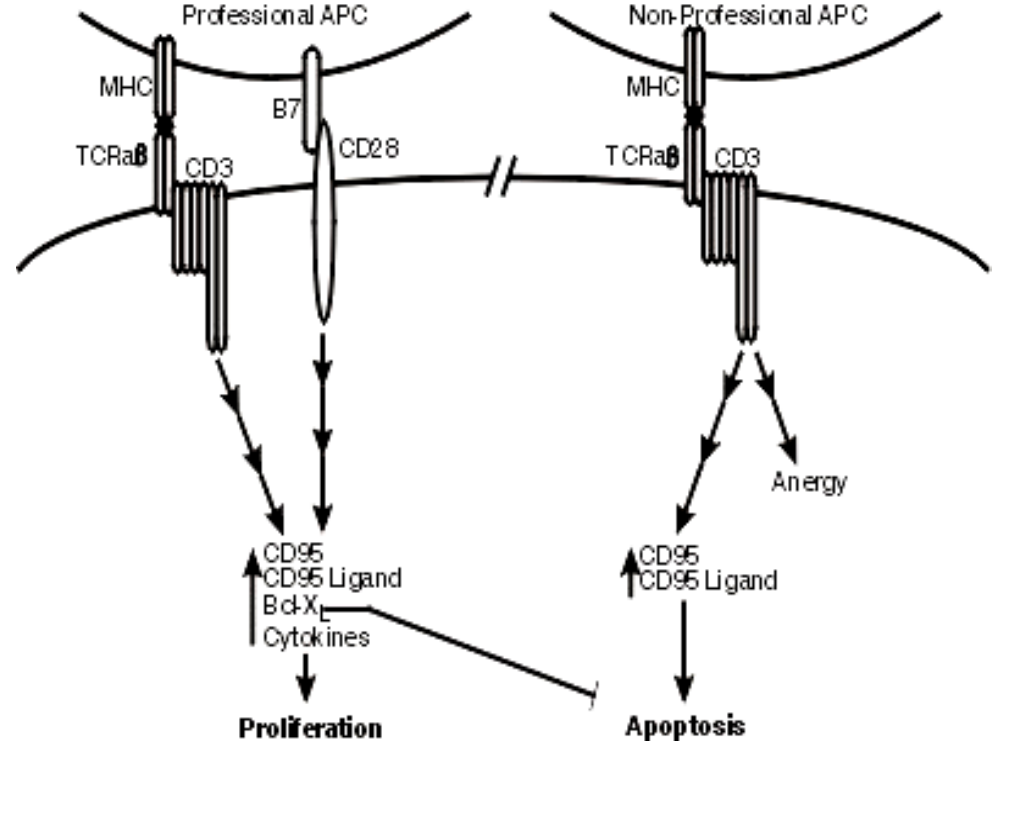
Figure 2: Pathways of T-cell stimulation [2] – The role of costimulation in delaying the onset of apoptosis induced cell death (AICD). Ligation of the T cell receptor in the presence or absence of costimulation results in increased expression of both CD95 and its ligand. However when professional antigen-presenting cells (APC) that express the B7 surface antigen stimulate T cells via CD28-mediated costimulatory signals, augmentation of TCR-induced cytokine production goes on for several days. The cells become susceptible to CD95/CD95 ligand-mediated apoptosis. In contrast when T cells are stimulated directly through the TCR in the absence of B7 surface antigen costimulation they are signaled to either enter a state of unresponsiveness (anergy) or are induced to undergo apoptosis due to interaction of CD95 with its